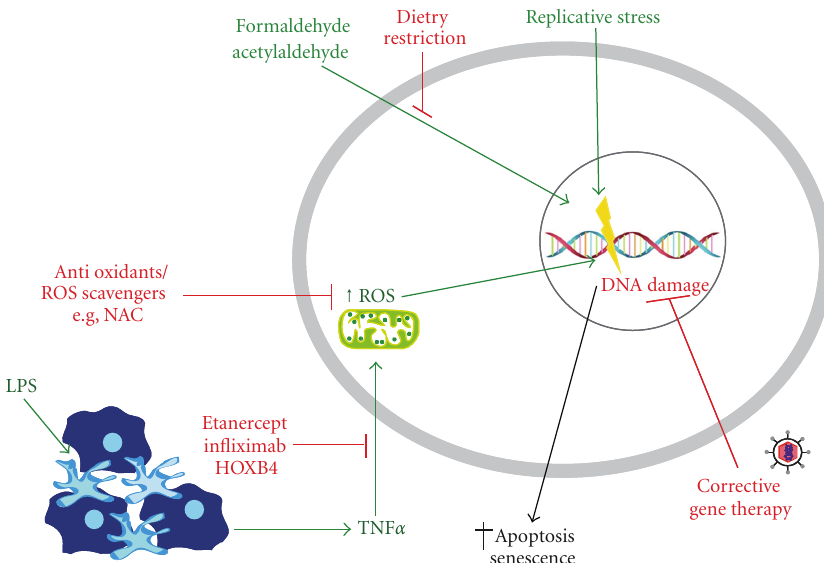
Figure 2: Potential novel therapeutic approaches for the prevention of FA HSC depletion. The potential physiologic mediators of FA HSC depletion, including replicative stress, TNF- α , ROS, lipopolysaccharide (LPS), and reactive aldehydes, are depicted as green arrows. Exposure of FA HSCs to these agents/conditions would be predicted to result in DNA damage and ultimately loss of the cell via apoptosis or senescence. Novel therapeutic modalities that directly target these HSC-depleting stimuli are shown in red. Controlling dietary consumption of certain food types (e.g., alcohol) may reduce the production of high levels of reactive aldehyde species in FA patients. Intracellular ROS could be decreased via treatment with antioxidants or ROS scavengers. Proinflammatory cytokine signaling could be targeted by interfering with ligand-receptor binding (e.g., using etanercept or infliximab to block interaction of TNF- α with its receptors) or by inhibiting downstream signaling cascades, as demonstrated for HOXB4 overexpression in the context of TNF- α signaling. Finally, gene therapy approaches o ff er the possibility of restoring expression of a functional FA gene into patient